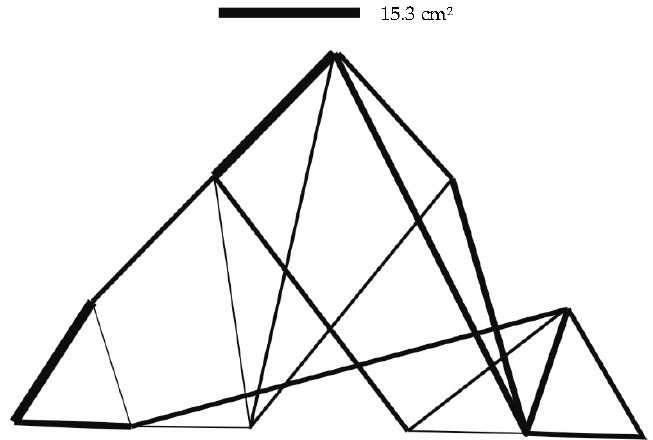
Figure 9. Truss structure after optimization—15 individuals in population (case c). Example III.